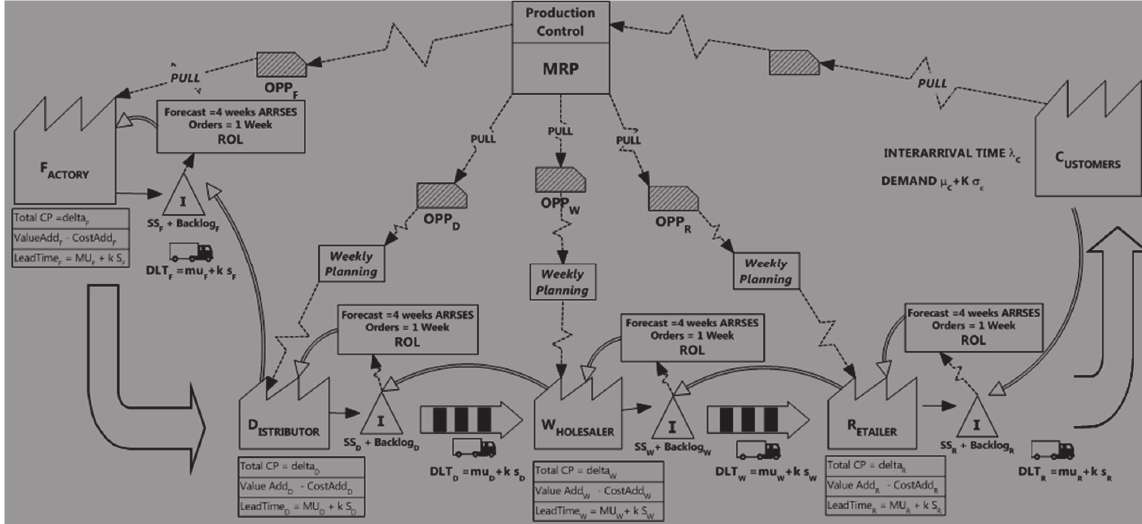
Fig. 3. Mixing strategies for MTS and MTO penetration in